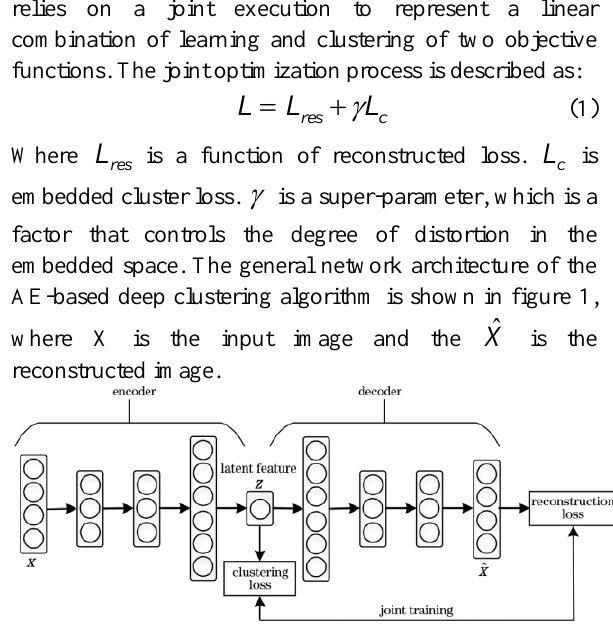
Figure 1. Architecture of